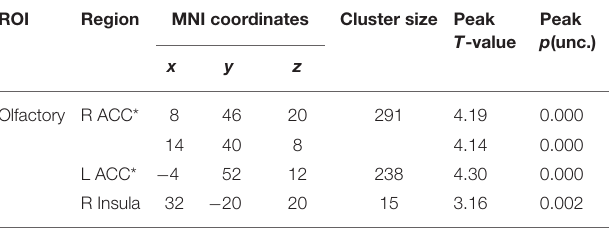
TABLE 2 | Food odors vs. Non-food odors in all subjects. MNI coordinates Cluster size Peak